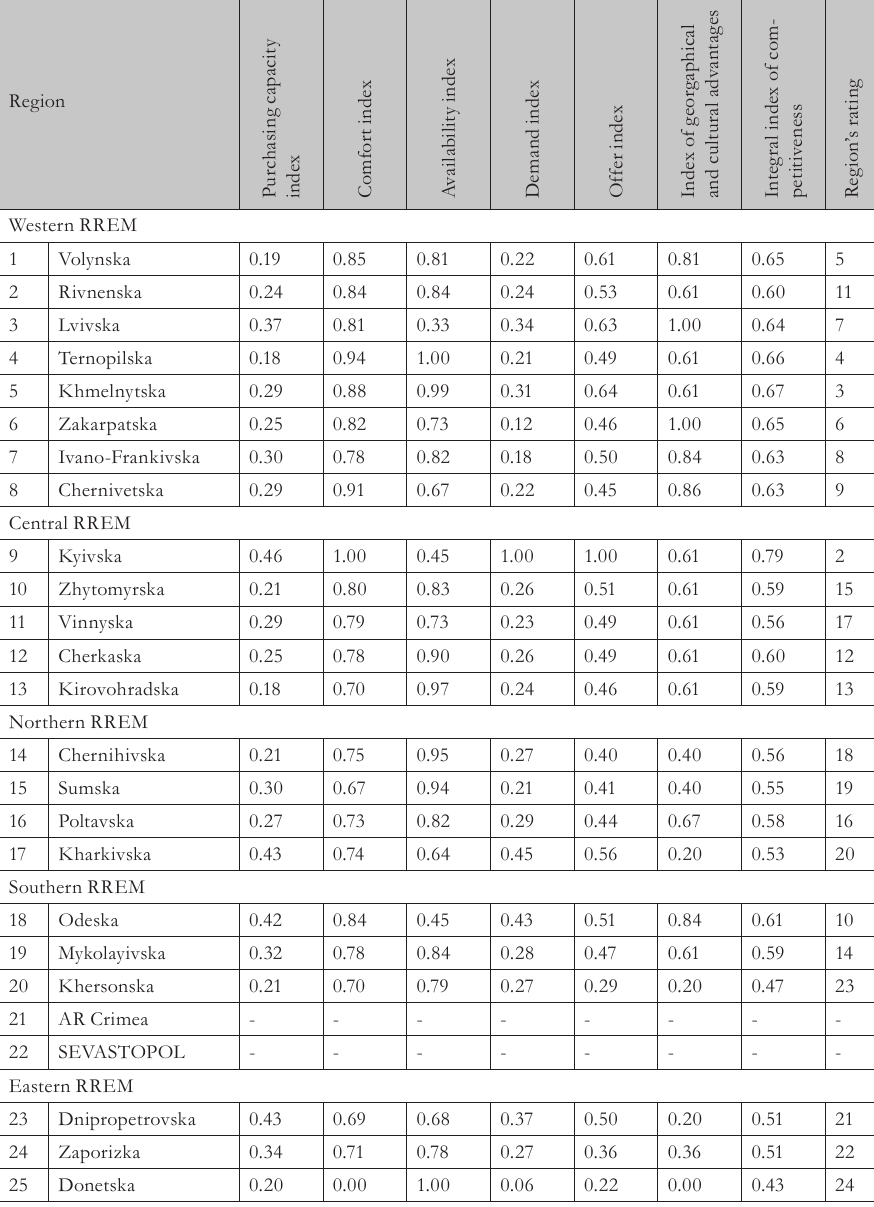
Tab. 8 – Integral indices of real estate market competitiveness for Ukraine oblasts by their division into RREM, on January 1, 2017, (excluding the temporarily occupied territory of the Autonomous Republic of Crimea, the city of Sevastopol and parts of the zone of anti-terrorist operation in Donetska and Luhanska oblasts). Source: own research